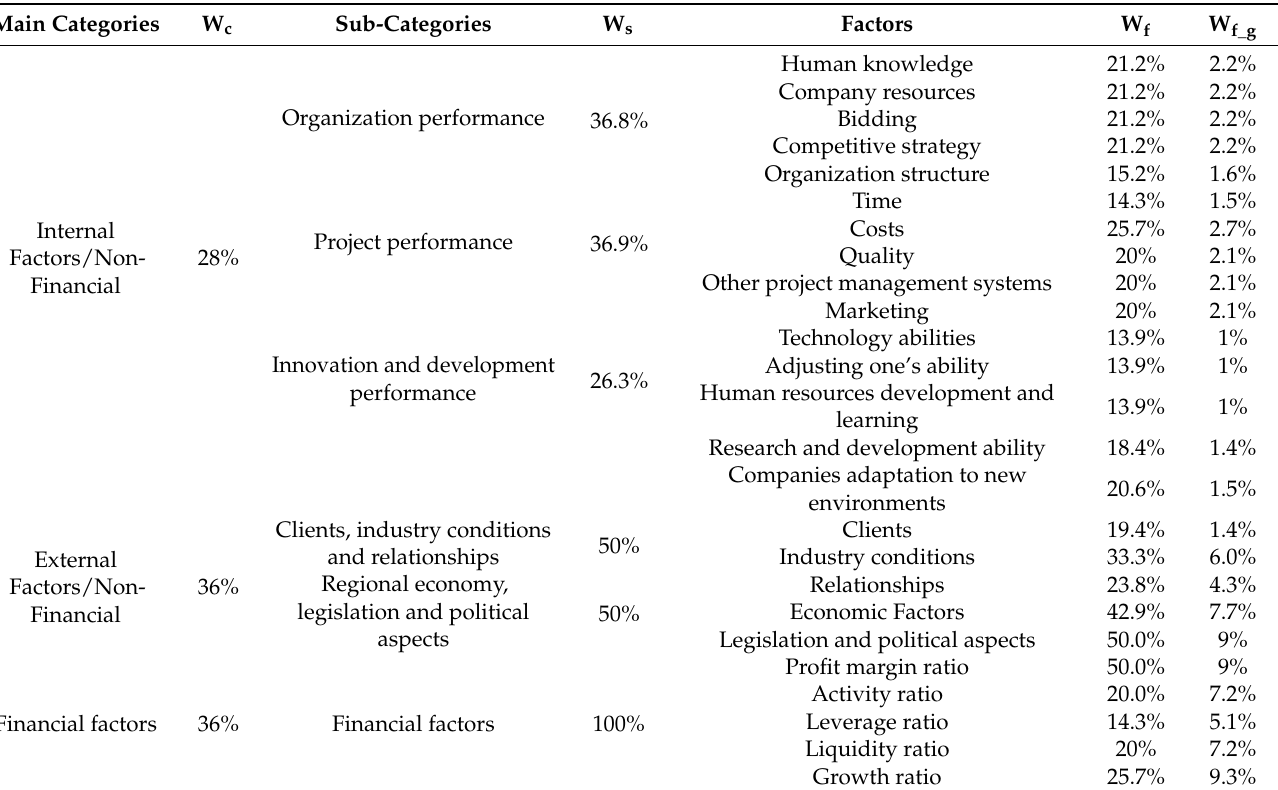
Table 1. Weights of main categories, sub-categories and